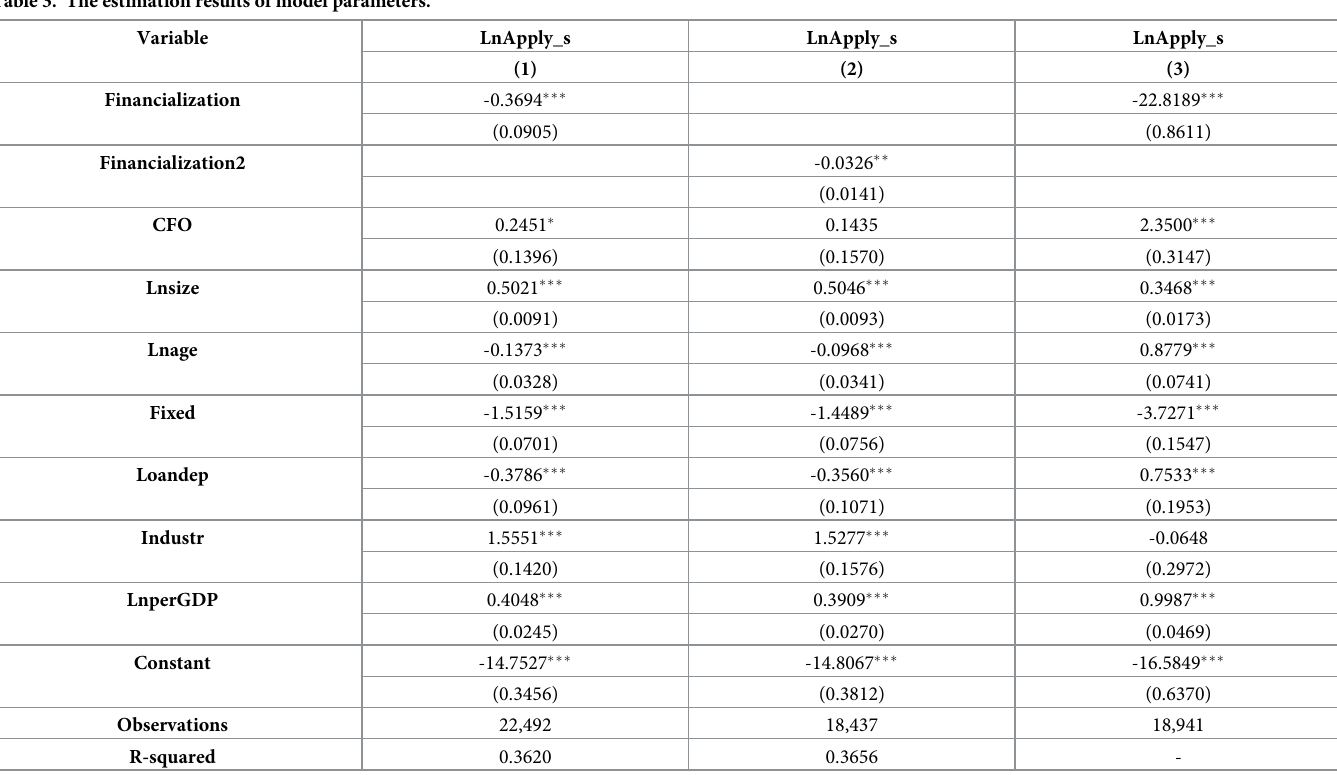
Table 3. The estimation results of model